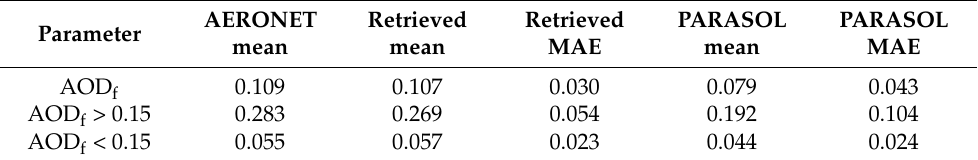
Table 3. Statistical results for the mean of AERONET, retrieved and PARASOL AOD f.